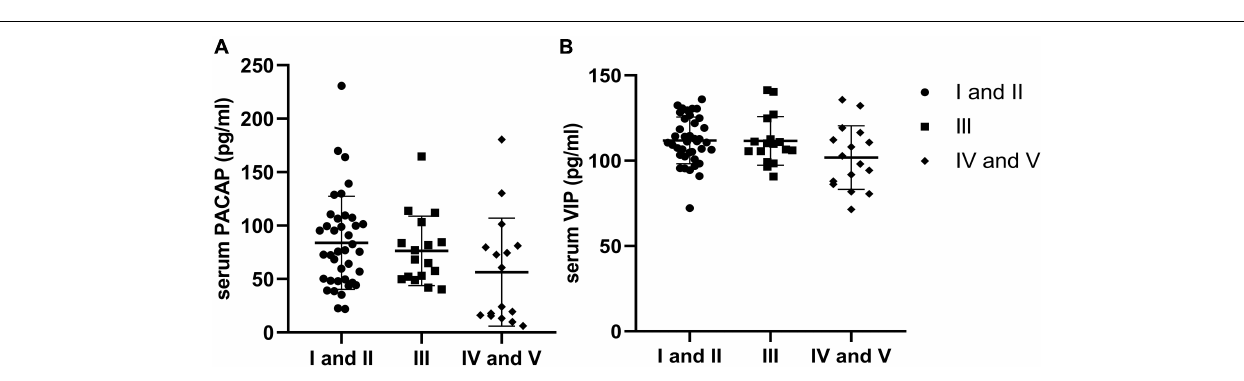
FIGURE 3 | Distribution of serum levels of pituitary adenylate-cyclase activating polypeptide (PACAP) and vasoactive intestinal peptide (VIP) by Hoehn–Yahr (H-Y) stage. (A) There were no significant differences in the distribution of serum PACAP levels by H-Y stage in Parkinson’s disease (PD) patients ( P > 0.05). (B) There were no significant differences in the distribution of serum VIP levels by H-Y stage in PD patients ( P >